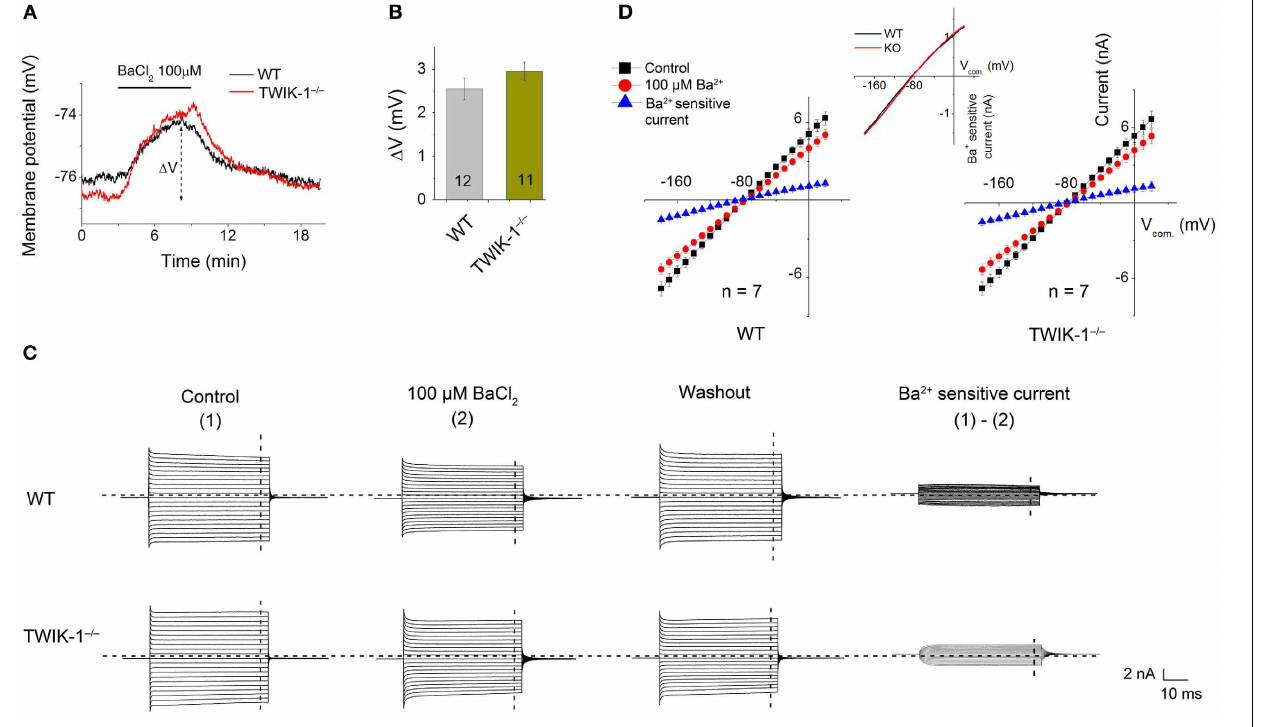
FIGURE 5 | Ba 2 + at micromolar concentration does not eliminate the inward component of passive conductance in TWIK-1 − / − mice. (A) 100 μ M BaCl 2 induced similar Vm depolarization in WT and TWIK-1 − / − astrocytes. (cid:2) V indicates the plateau Vm depolarization at 5min in BaCl 2 . (B) 100 μ M BaCl 2 induced (cid:2) V was not differed between WT and TWIK-1 − / − astrocytes. (C) The representative whole cell passive currents before and